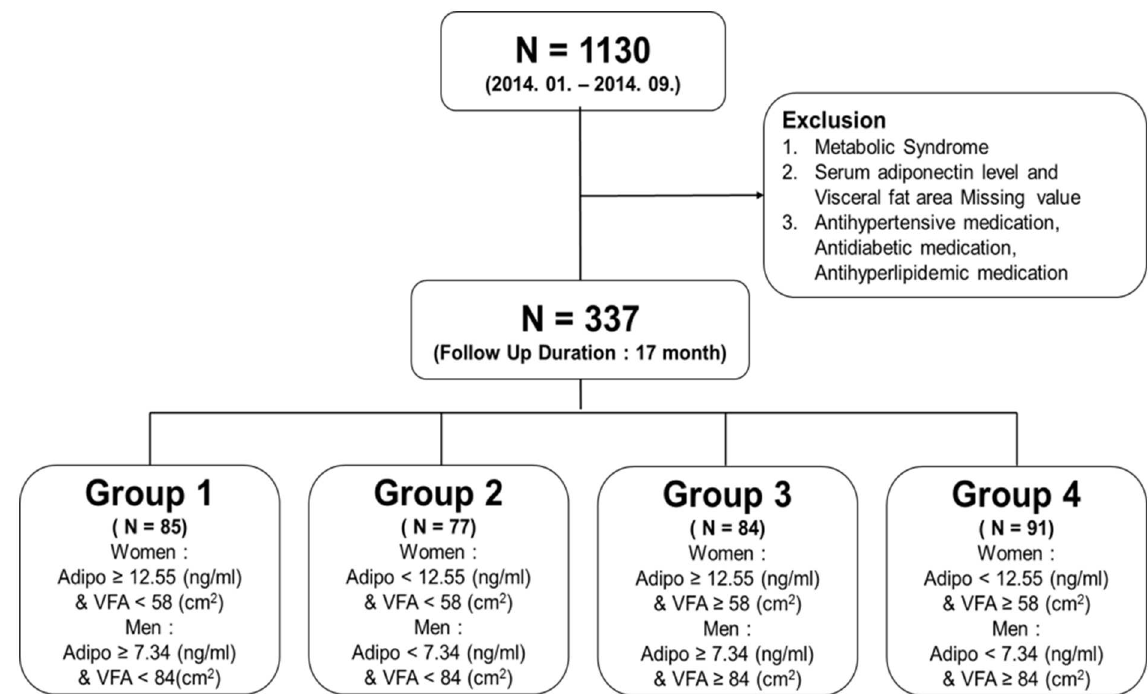
Fig 1. Study population. Adipo, Serum adiponectin level; VFA, Visceral fat